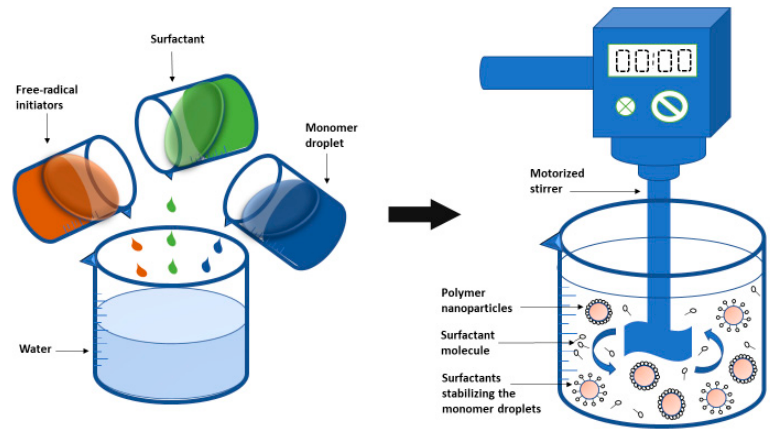
Figure 6. Schematic representation of the emulsion polymerization method.